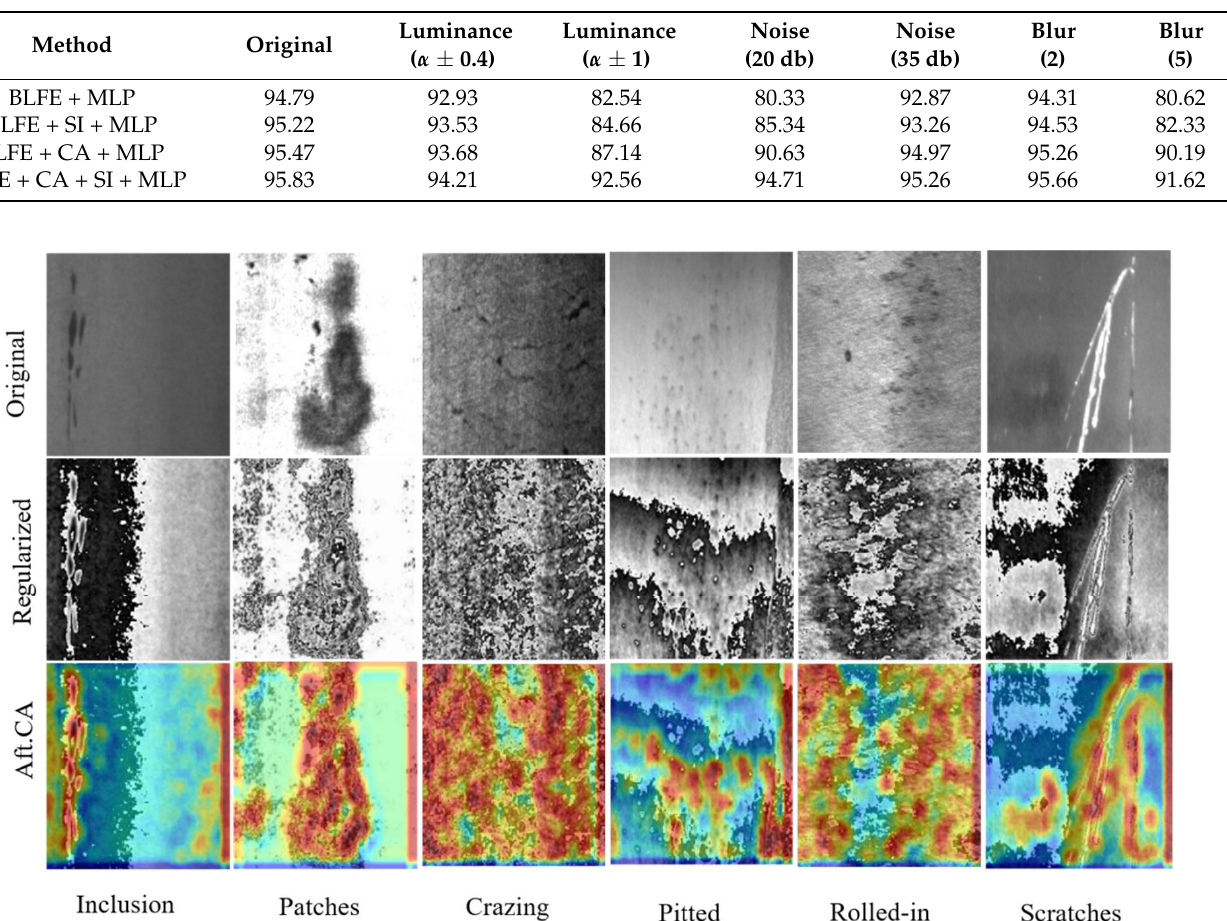
Table 1. The classification accuracy (%) of CASI-Net in NEU dataset.